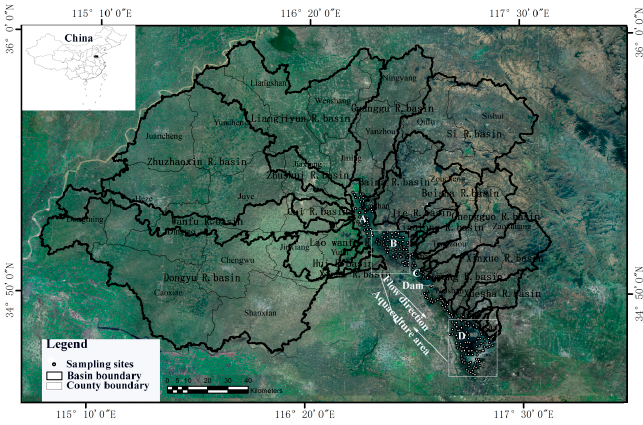
Figure 1. Location of sampling sites in Nansi Lake (A: Nanyang sub-lake; B: Dushan sub-lake; C: Zhaoyang sub-lake; D: Weishan sub-lake) and its main inflow rivers basin.